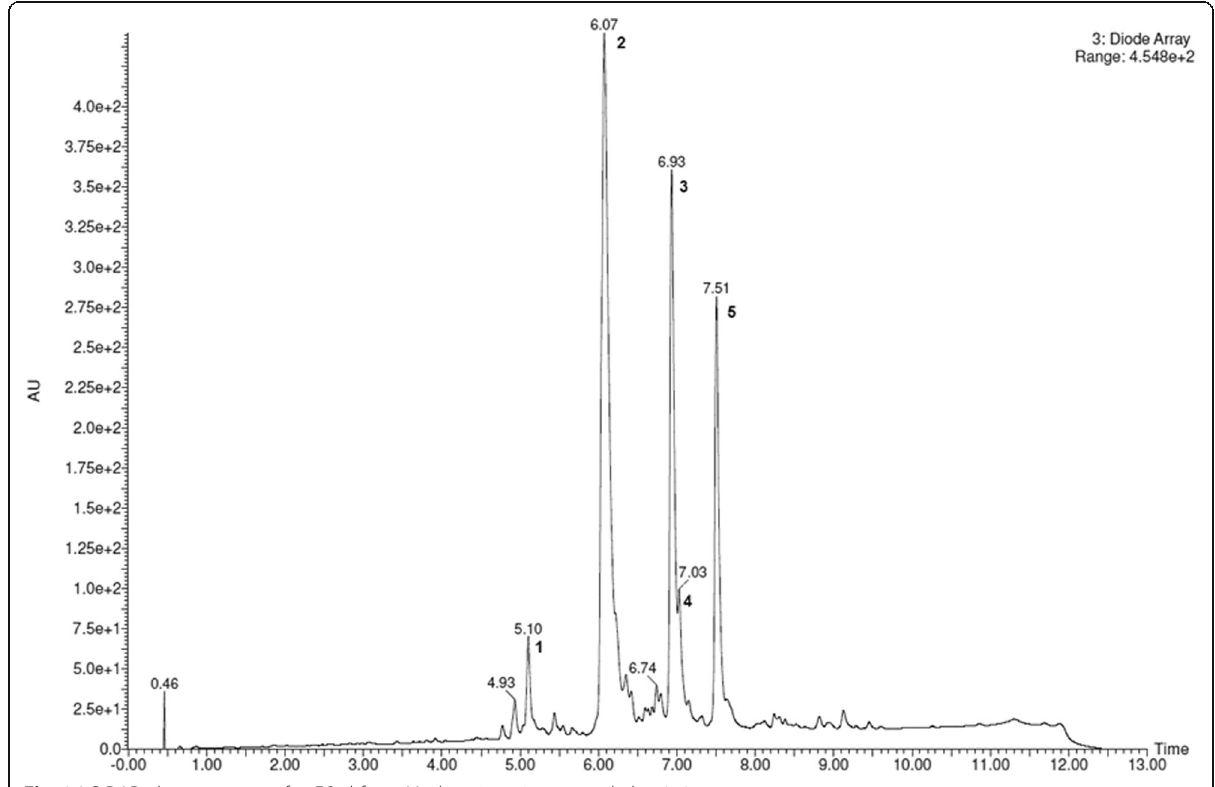
Fig. 2 LC-DAD chromatogram of 11FO d from Maclura tinctoria as recorded at 270 nm